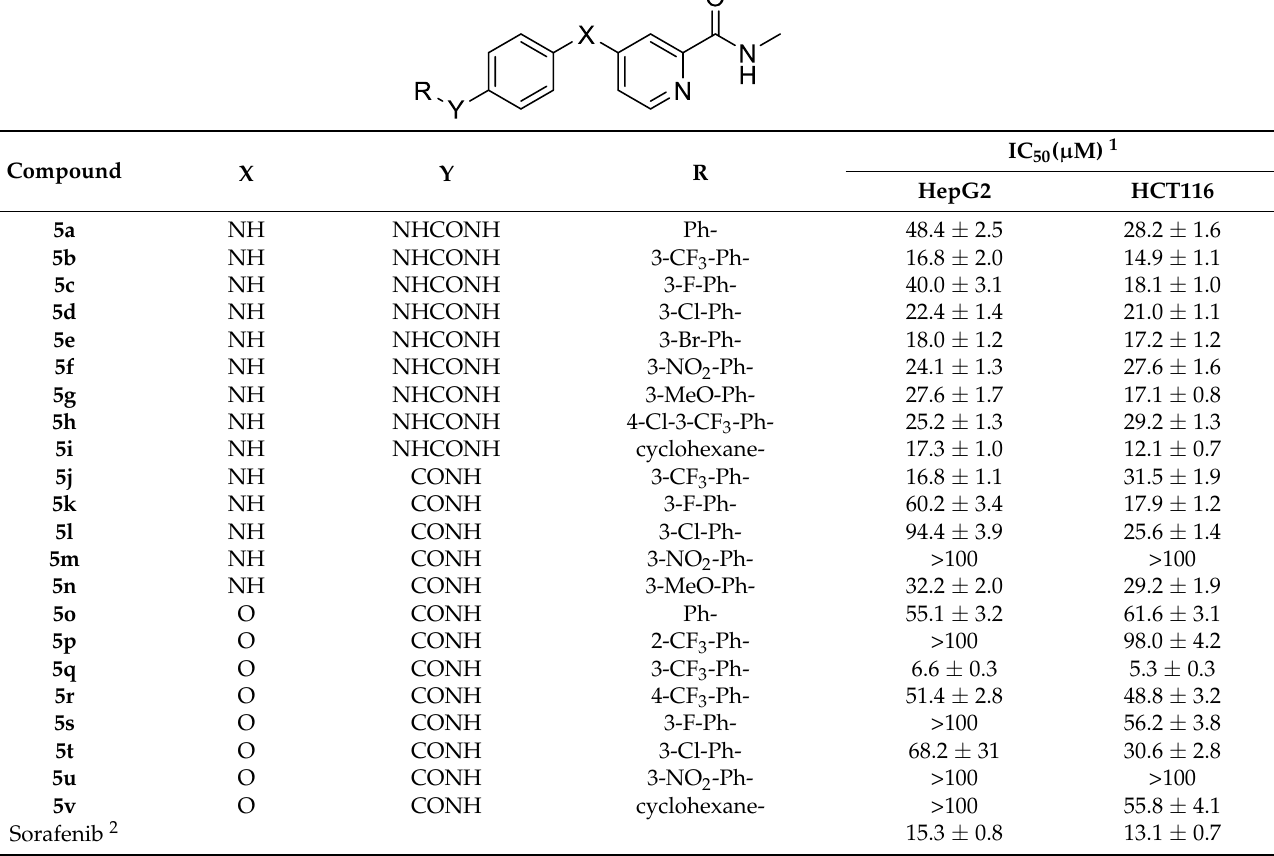
Table 1. The antiproliferation activities of compounds 5a – v against HepG2 and HCT116.